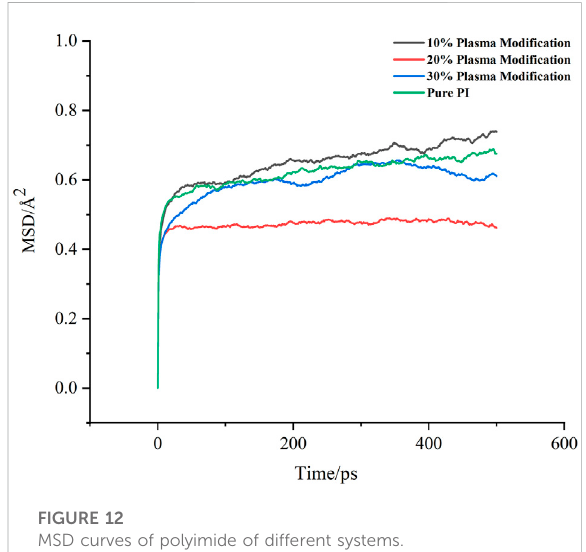
FIGURE 12 MSD curves of polyimide of different systems.